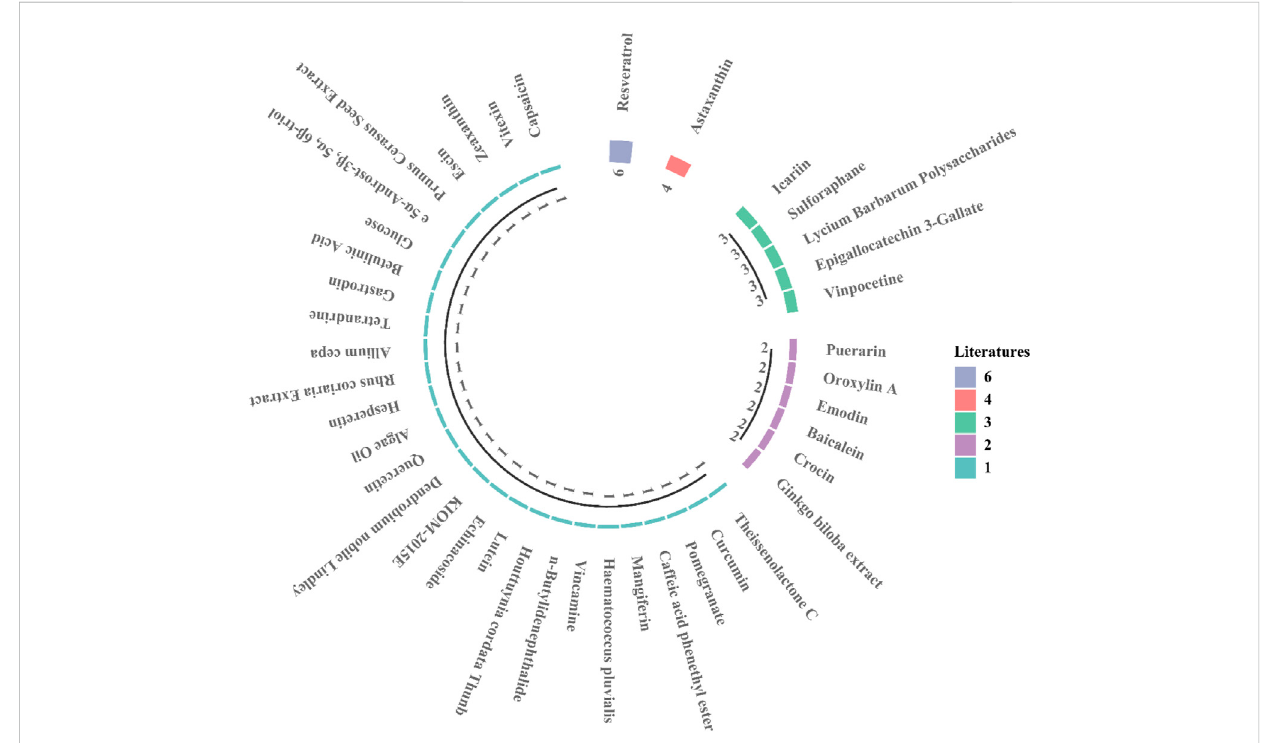
The current number of research articles for each natural compound. Resveratrol: 6 studies; astaxanthin: 4